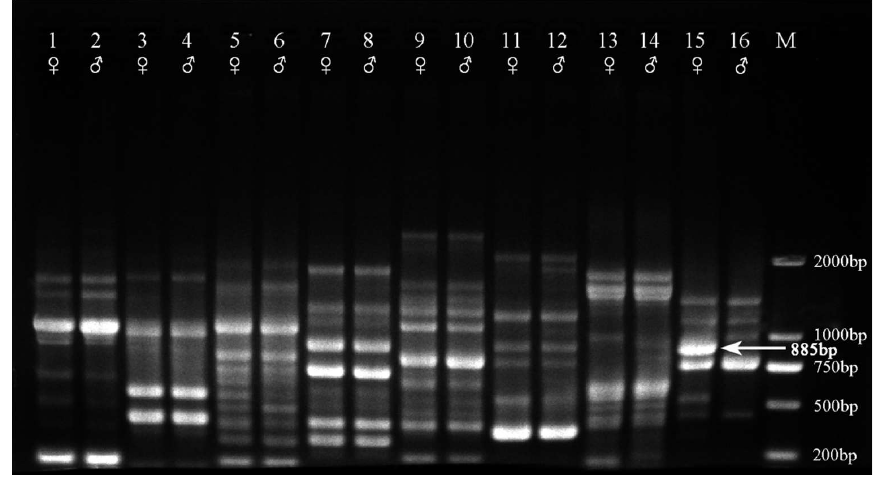
Figure 1. Part of the RAPD screening products of bulk DNA from each of the 140 male and female H. rhamnoides samples via decamer primers (Lanes 1, 3, 5, 7, 9, 11, 13, and 15: female; Lanes 2, 4, 6, 8, 10, 12, 14, and 16: male). The female-specific 885 bp band is indicated with an arrow. M, DNA Marker DL2000 (Takara, Dalian, China).